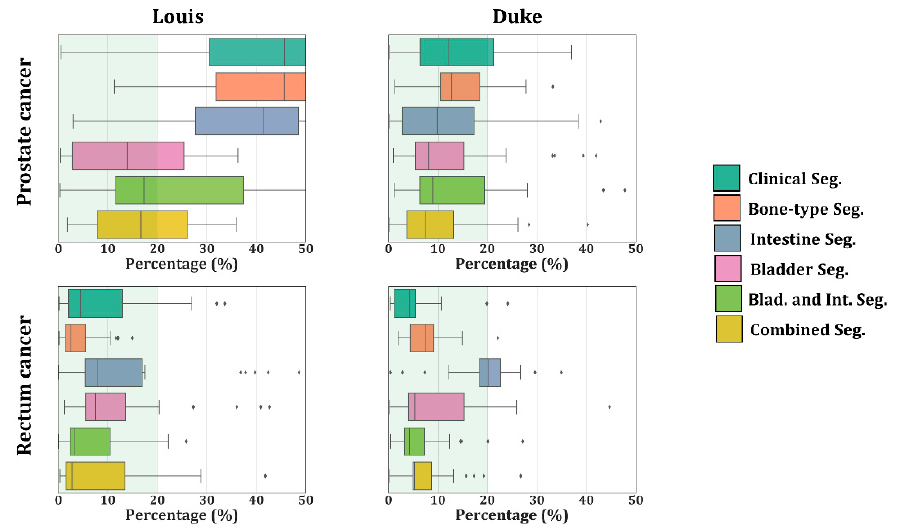
Figure 6. Boxplot with the maximum |dRD| in the male models. |dRD| was normalized to the maximum SAR for each tissue in the benchmark and expressed as a percentage (%). The inter-quartile range represents the middle 50% of the dataset, where the right box line represents 75% of the dataset that falls below the upper quartile, the left line represents 25% of the dataset that falls below the lower quartile, and finally, the middle line represents the median. The line extending from the box represents 2.5% and 97.5% limits of the dataset.